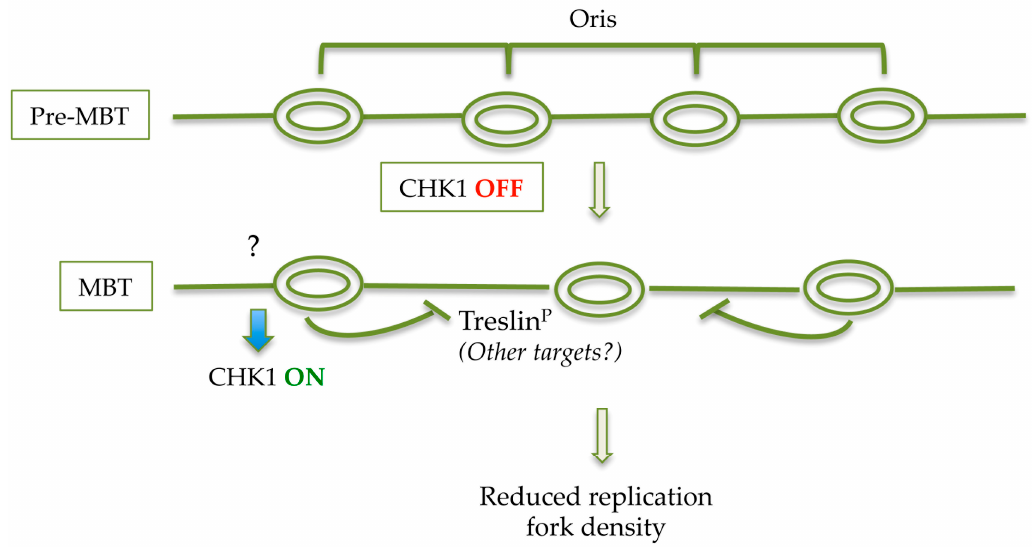
Figure 2. Speculative model of decreased origin density at MBT. Developmental activation of CHK1 at MBT stimulated by as yet unclear cues (question mark), induces local phosphorylation of Treslin (and probably of other targets that remain to be identified) which suppresses initiation of DNA synthesis within a replication cluster thus leading to a reduced replication origins density.